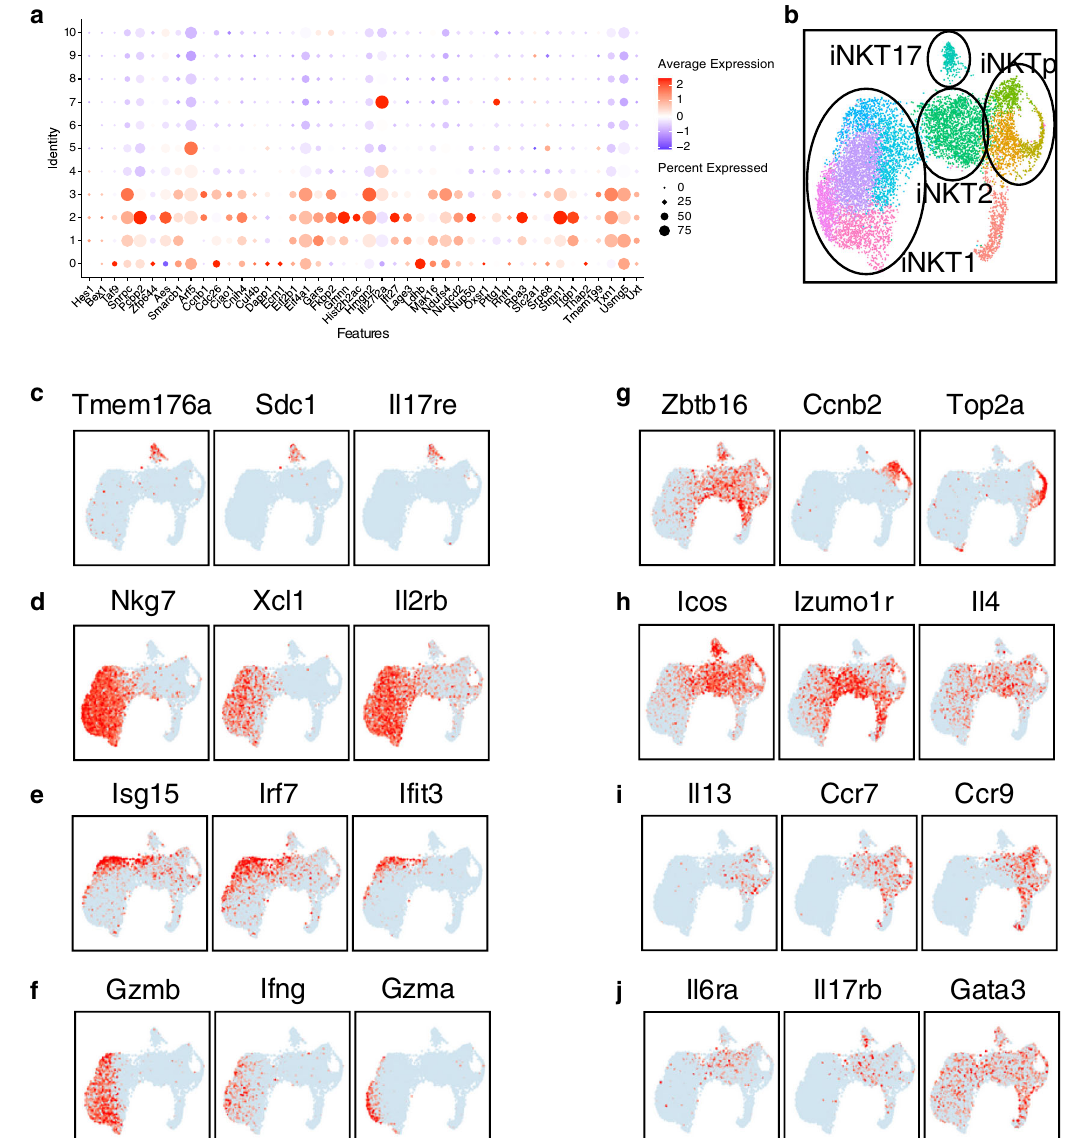
Fig. 3 Gene expression pro fi le of stage 0 iNKT cells. a Dot plot showing scaled expression of the 44 genes previously described as the iNKTp signature, for each cluster colored by average expression of each gene in each cluster scaled across all clusters. Dot size represents the percentage of cells in each cluster with more than one read of the corresponding gene. b Summary of the UMAP de fi ned in Fig. 1 with major NKT subset populations de fi ned by gates. c Expression of three typical genes used to de fi ne iNKT17 cells. d Expression of three typical genes used to de fi ne iNKT1 cells. e Expression of three typical genes used to de fi ne interferon signaling genes. f Expression of three typical genes used to de fi ne cells in cluster 9. g – j Expression of twelve genes used to illustrate and de fi ne the diversity amongst iNKT2/cycling